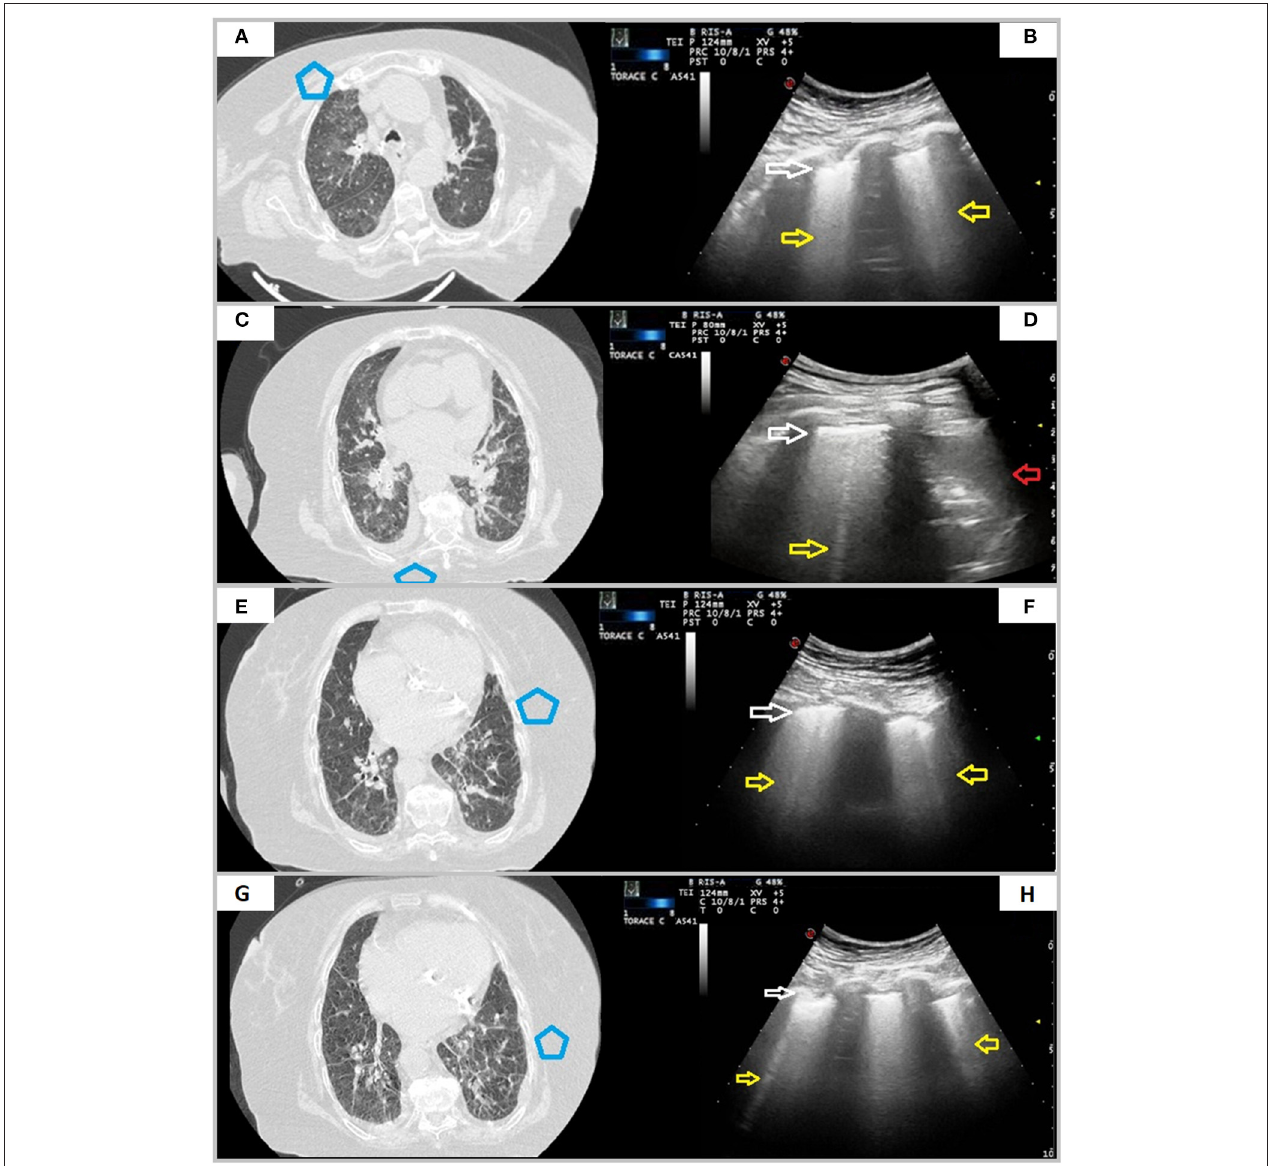
FIGURE 5 | A case of overlapping cardiogenic pulmonary edema. A 76-year-old female patient presenting in ED with dyspnea for 6 days. The RT-PCR assay on nasopharyngeal swab resulted positive for SARS-CoV-2 infection. In (A,C,E,G) , axial CT scans reveal smooth interlobular septal thickening, fissural thickening, mixed GGO and consolidation with central distribution, increased artery to bronchus ratio, cardiomegaly, and bilateral pleural effusion. In (B,D,F,H) , ultrasound scans with a convex probe (6 MHz) and thoracic setting, corresponding to the blue boxes in the respective CT scans, show an irregular and thickened hyperechoic pleural line (white arrow) followed by focal or coalescent B-lines (yellow arrows). Right posterior ultrasound scan in (H) also underlines presence of pleural effusion (red arrow).